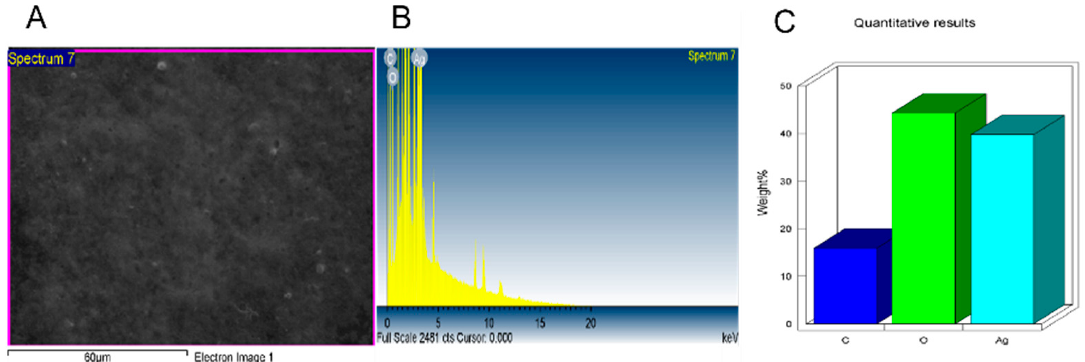
Figure 7. Surface morphology of L-AgNPs ( A ) and quantitative data analysis of images, weights of the of carbon, oxygen and silver atoms using EDS ( B , C ).